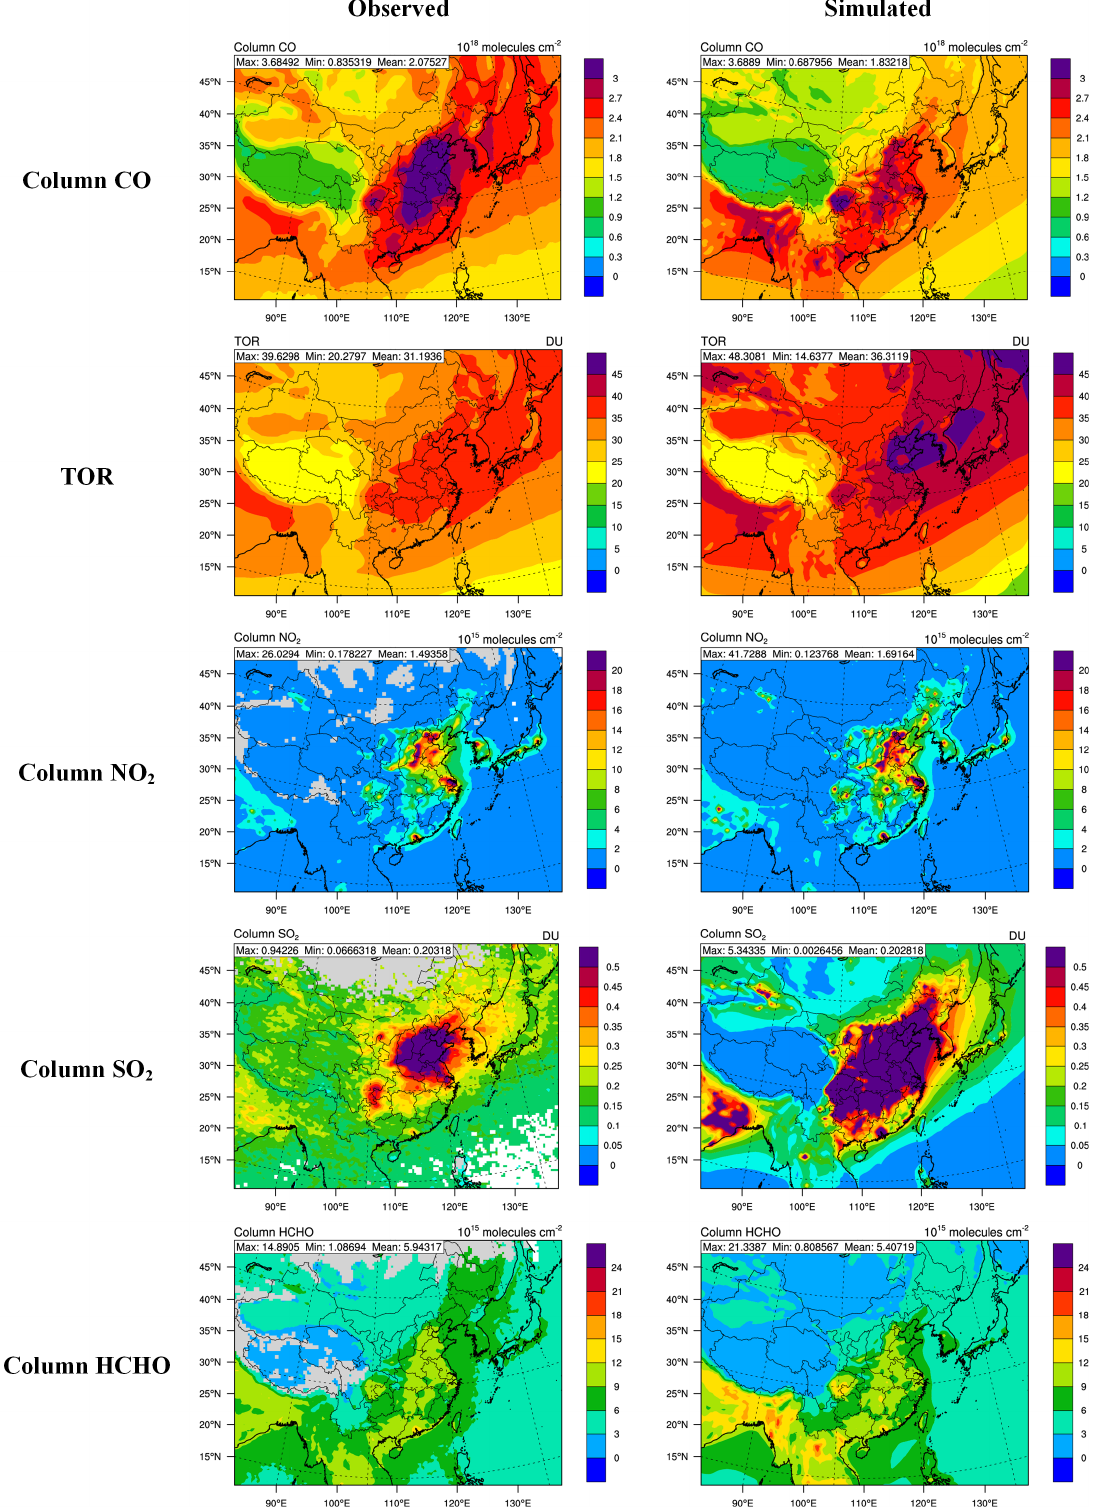
Figure 6. Spatial distribution of satellite-derived and simulated multi-year means of column CO, TOR, column NO 2 , column SO 2 , and column HCHO under the climatological application for the time period